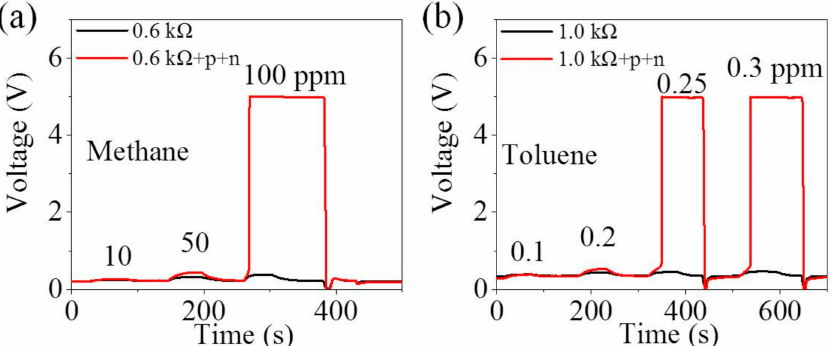
Figure 5. Output voltage of ( a ) MP-4 to methane from 10 to 100 ppm and ( b ) TGS 2602 to toluene from 0.1 to 0.3 ppm in the traditional circuit and the interlocking p+n FET circuit under humidity of